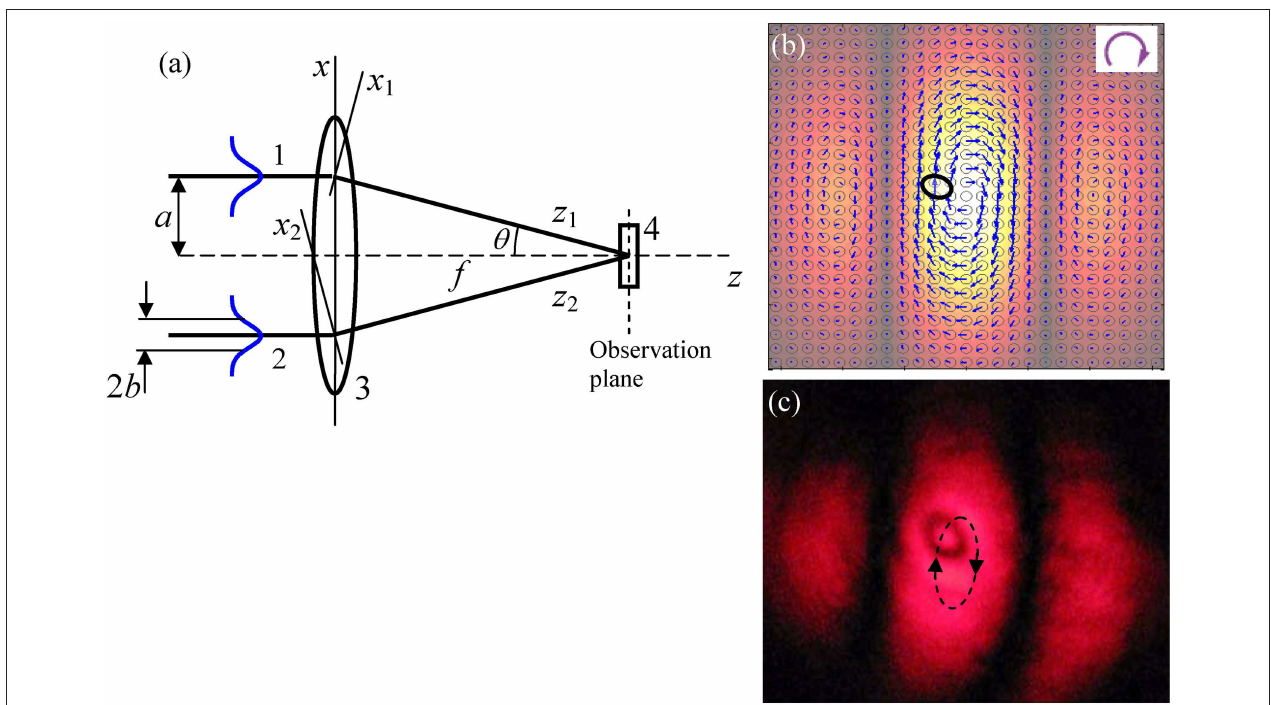
FIGURE 12 | (a) Experimental scheme for realization of optical trap with inhomogeneous polarization [64, 106]: 1 and 2 are the input beams, 3 is the objective lens, the cuvette 4 with water-suspended particles is placed in the focal plane. (b) Simulated and (c) experimental pictures observed in the cuvette; (b) the particle trace is conventionally presented by the black oval; arrows show the transverse SM lines [cf. Equation (29)] in the case of right circular polarization of the input beams (indicated in the right upper corner); (c) the dashed oval with arrows schematically illustrates the particle